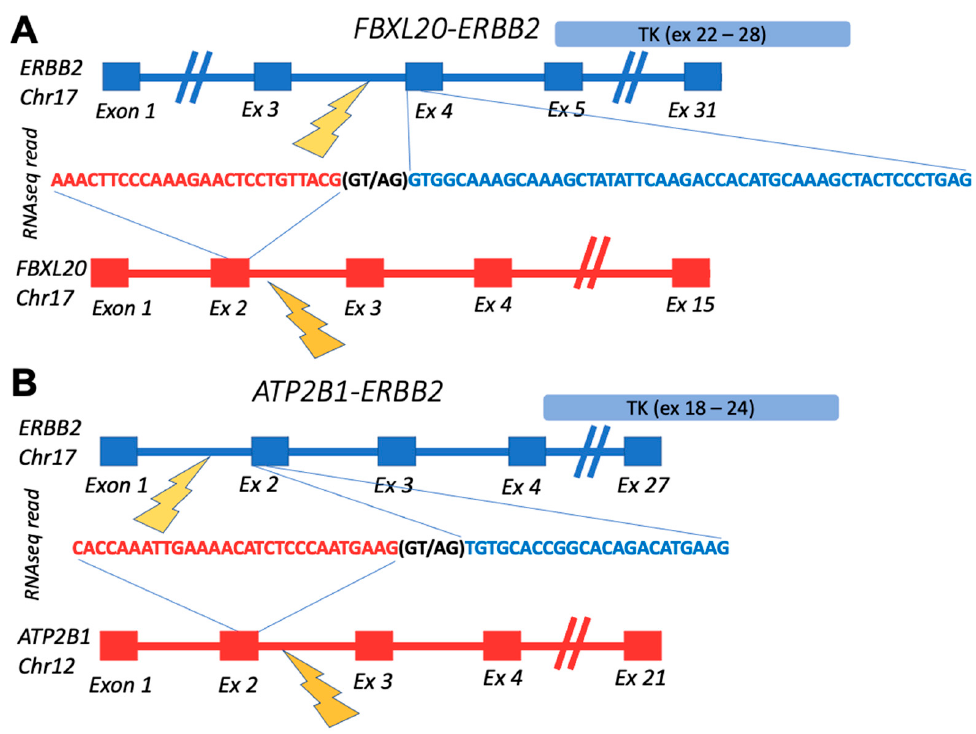
Figure 2. Schematic representation of fusion transcripts identified in BC105 sample: ( A ) gene structures upstream and downstream of FBXL20-ERBB2 fusion site; ( B ) gene structures upstream and downstream of ATP2B1-ERBB2 fusion site. TK, ERBB2 -encoded tyrosine kinase domain.